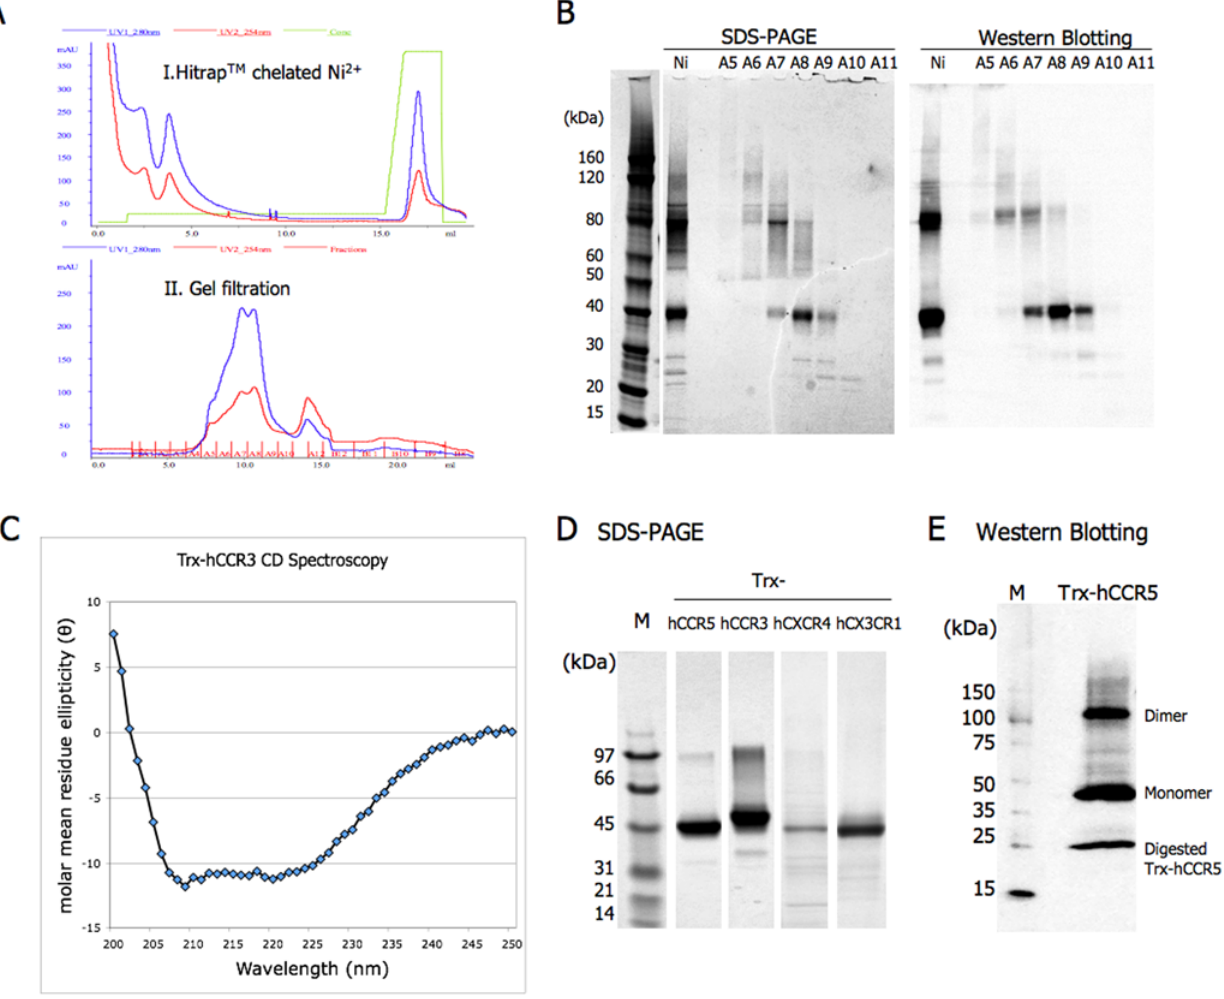
Figure 7. Large-scale purification, identification and studying secondary structure of Trx-hCRs. A) Two-step purification of Trx-hCCR3 from membrane fractions. (I) Ni 2 + affinity purification of His 6 -tagged proteins using a Hitrap chelating HP 5 ml column. (II) Gel filtration purification using Superdex 200 10/300 GL. Both purification steps were preformed on an A¨KTA Purifier System. B) SDS-PAGE detection and Western blot identification of protein fractions of Trx-hCCR3. One of two duplicates of the SDS-PAGE was transferred onto a nitrocellulose membrane and subjected to Western blot using rabbit anti-human CCR3 monoclonal antibody. Lane Ni: 1/10 dilution of Trx-hCCR3 protein purified by Ni 2 + affinity column (I); Lane A5 through A11: protein fractions of Trx-hCCR3 corresponding to gel filtration purification (II). All the samples were prepared by mixing 15 m l of protein fractions with 5 m l of SDS Sample buffer (4 6 ). 10 m l of BenchMark His-tagged protein standard was loaded as protein marker. SDS-PAGE was performed in a NuPAGE Novex 4–12% Bis-Tris Gel (in 1 6 MES buffer, Invitrogen) and stained by Simple Blue SafeStain (Invitrogen). C) Circular dichroism (CD) spectroscopy of purified Trx-hCCR3. Secondary structure of Trx-hCCR3 was analyzed by CD spectroscopy using purified Trx- hCCR3 monomer at 37 u C with the concentration of 1 mg/ml in Buffer C. D) All 4 Trx-hCRs were purified and analyzed on SDS-PAGE with size markers and stained using Simple Blue SafeStain. E) Western blot identification of Ni 2 + affinity column-purified Trx-hCCR5. Fraction of Trx-hCCR5 in the first step of purification was diluted to 0.1 mg/ml and subjected to Western blot detection using rabbit anti-human CCR5 monoclonal antibody. ECL DualVue Western blot Marker was used as protein standard. The 3 bands reveal that different states of Trx-hCCR5 were able to bind Ni 2 + column. Judging from molecular weight, they may correspond to Trx-hCCR5 dimer, monomer, and truncated Trx-hCCR5, possibly, non-fused